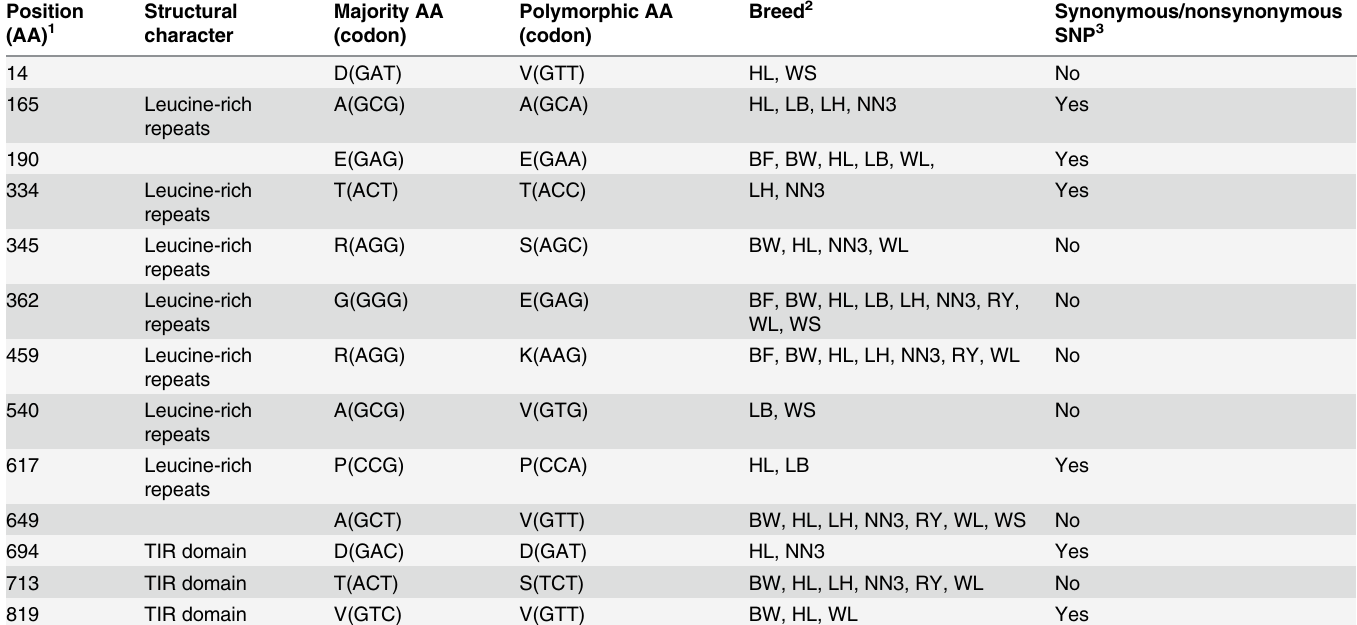
Table 1. Chicken TLR3 polymorphic sites in different